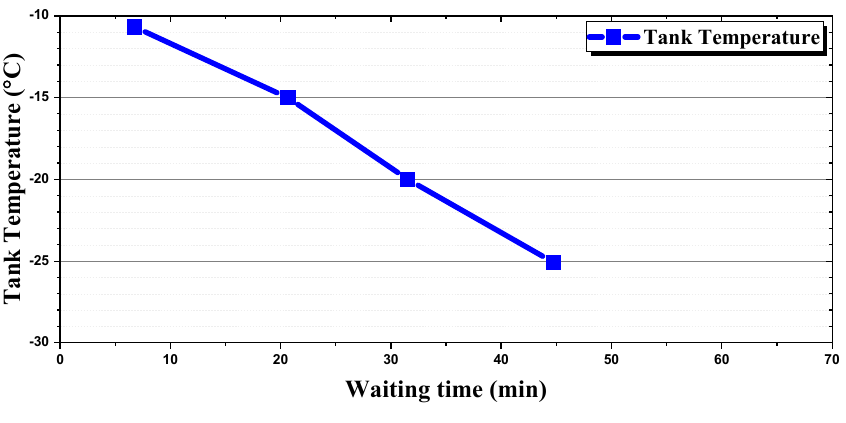
Figure 1. AdBlue defrost concept [17]